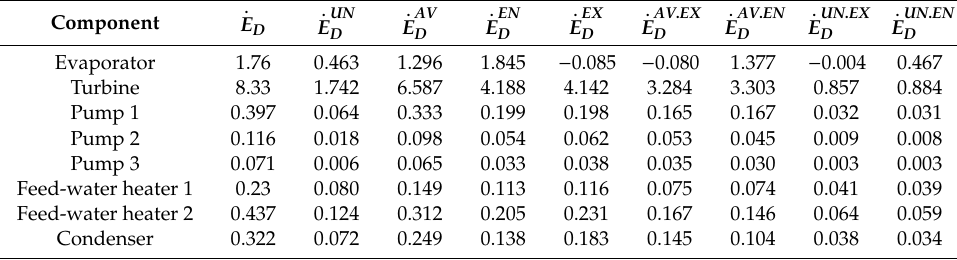
Table 10. The results of the advanced exergy analysis (per kW) for